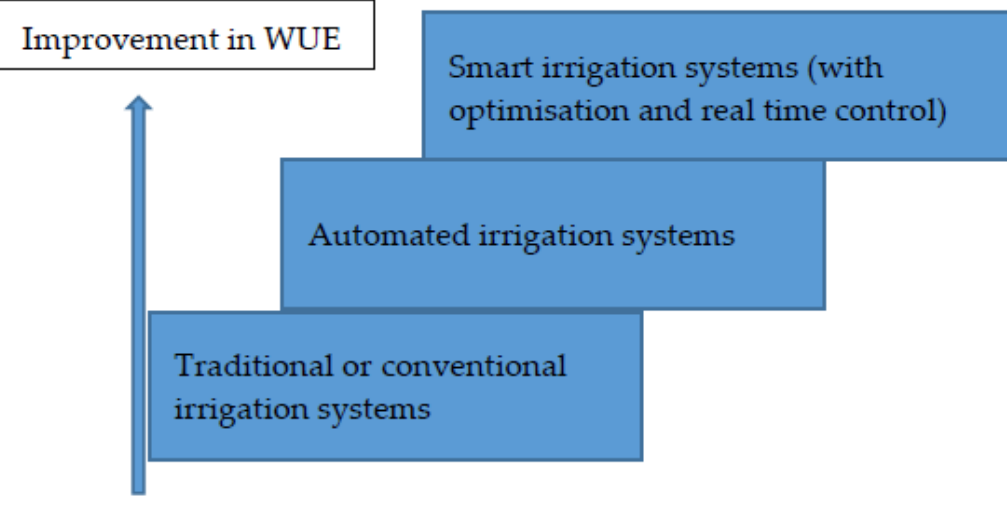
Figure 3. Advances in irrigation technologies.